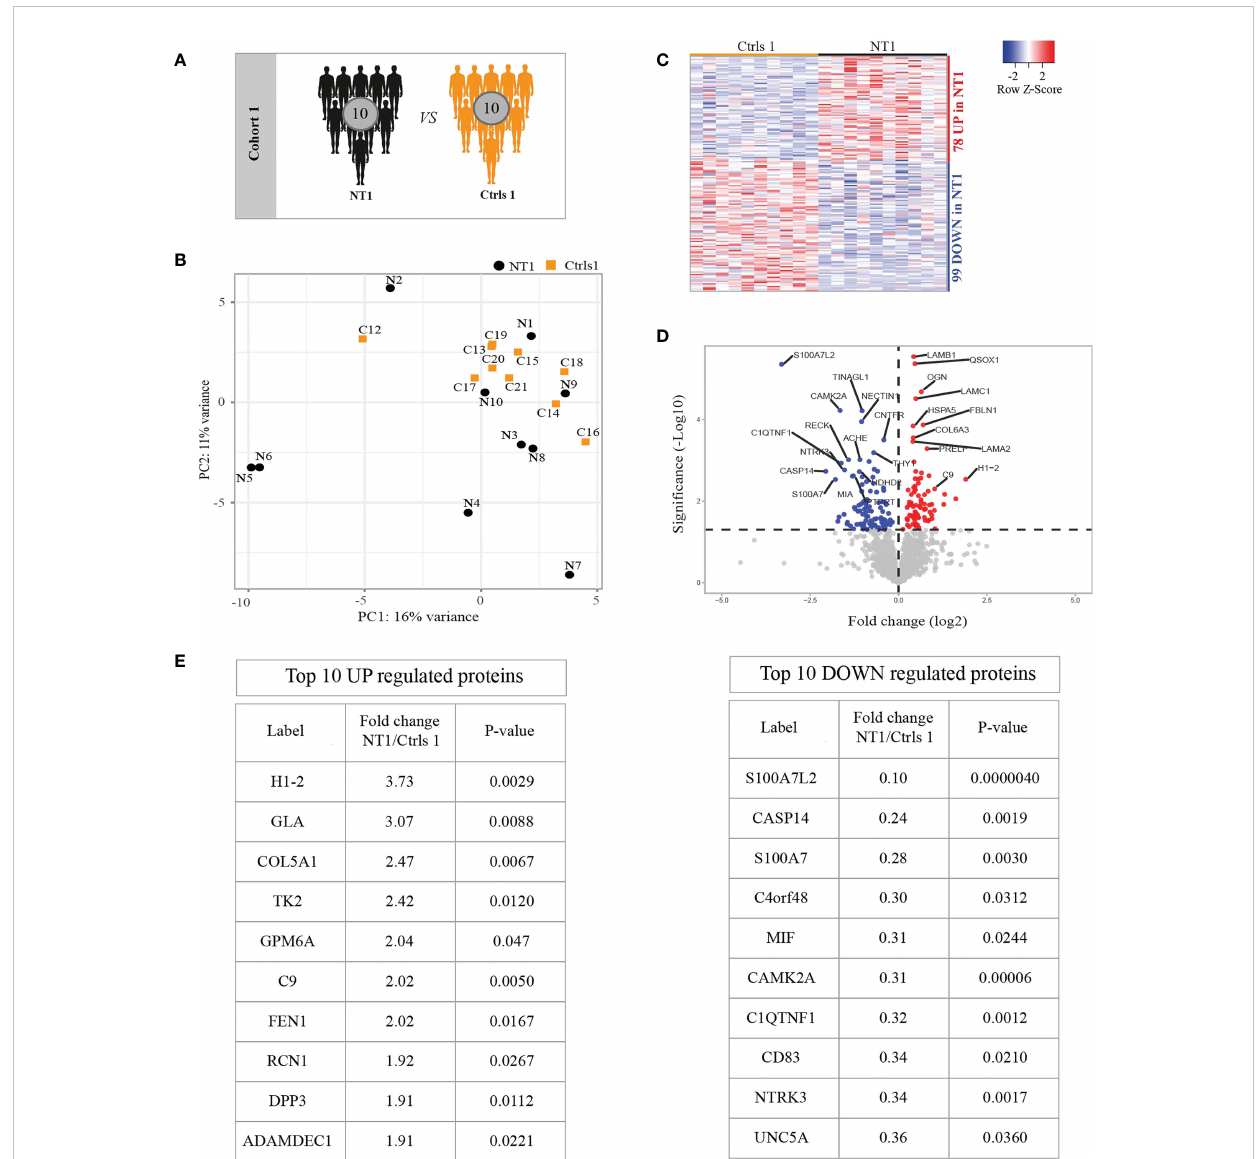
FIGURE 1 Differentially regulated proteins in the CSF of persons with NT1 compared to controls without neurological disease. (A) In cohort 1, the CSF proteome from 10 NT1 patients was compared to that of 10 controls with somatoform diseases. (B) Principal Component Analysis (PCA) visualization of the fi rst two principal components. (C) Heatmap of proteins with signi fi cantly different abundance in the CSF of NT1 patients vs. controls (p- value<0.05; Limma test). (D) Volcano plot representing the fold change (log2) of each protein in NT1 patients compared to controls and the p-value (-Log10), assessed with the Limma test. A signi fi cance threshold was set at p ≤ 0.05 (dashed line). (E) The top 10 up-regulated (left) and down- regulated (right) proteins in NT1